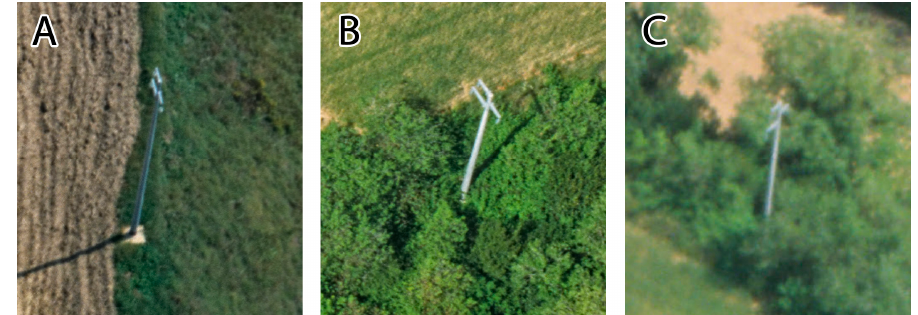
Figure 2. ( A ) A pylon with clearly visible foot (although only visible from one side). Some of the pylons stand on concrete sockets, but these were not measured. ( B ) Pylon with overgrown foot; ( C ) pylon with shielded foot.